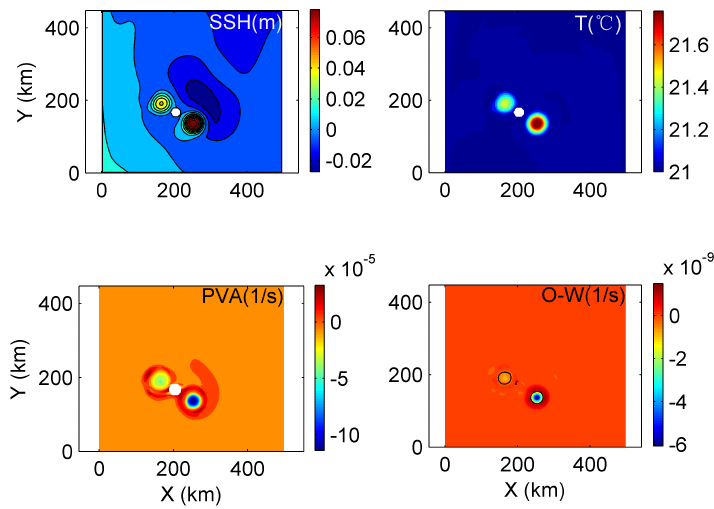
Figure 5. The warm eddy splits into two eddies during the interaction with an island of 20km in diameter on day 50 (the results shown are at 100m depth).